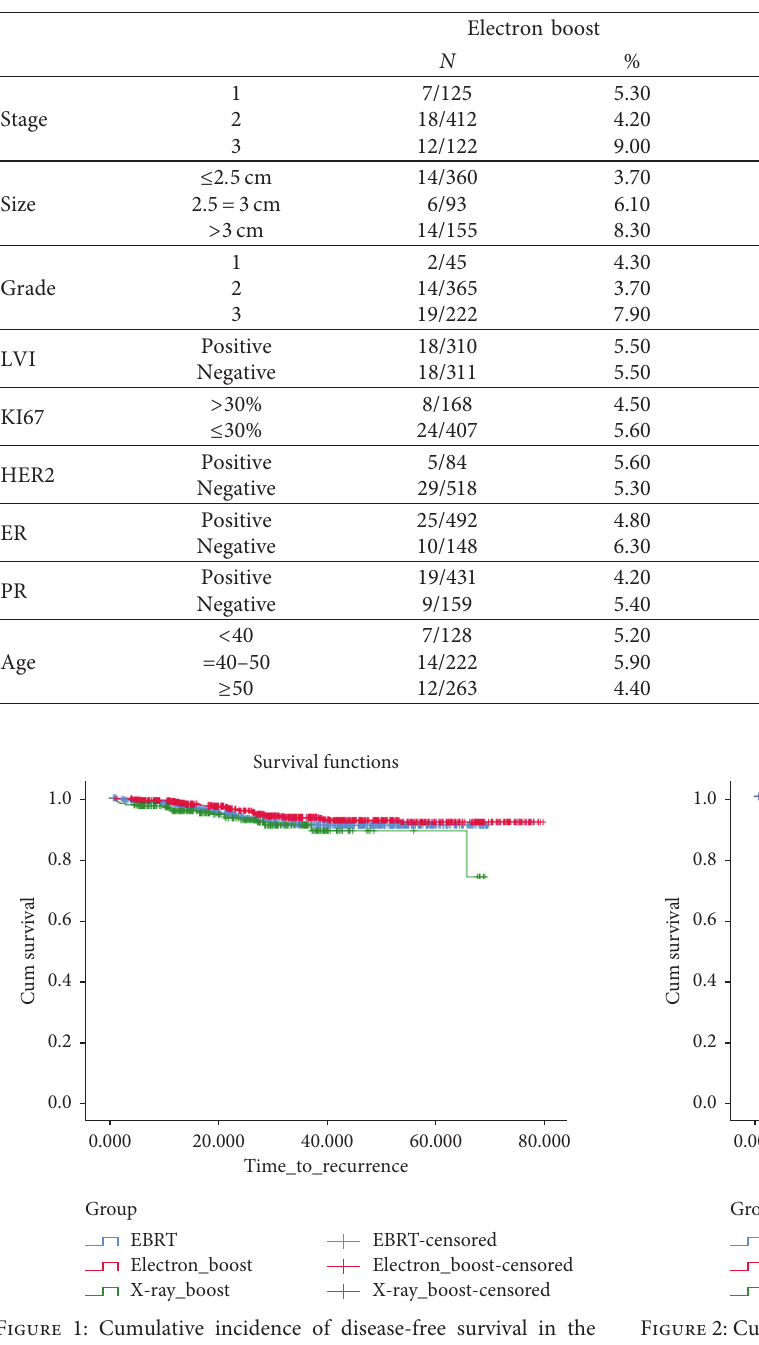
Table 3: Factors associated with recurrence in patients that received boost dose by IORT ( P value was considered concerning each variable that has the most risk).